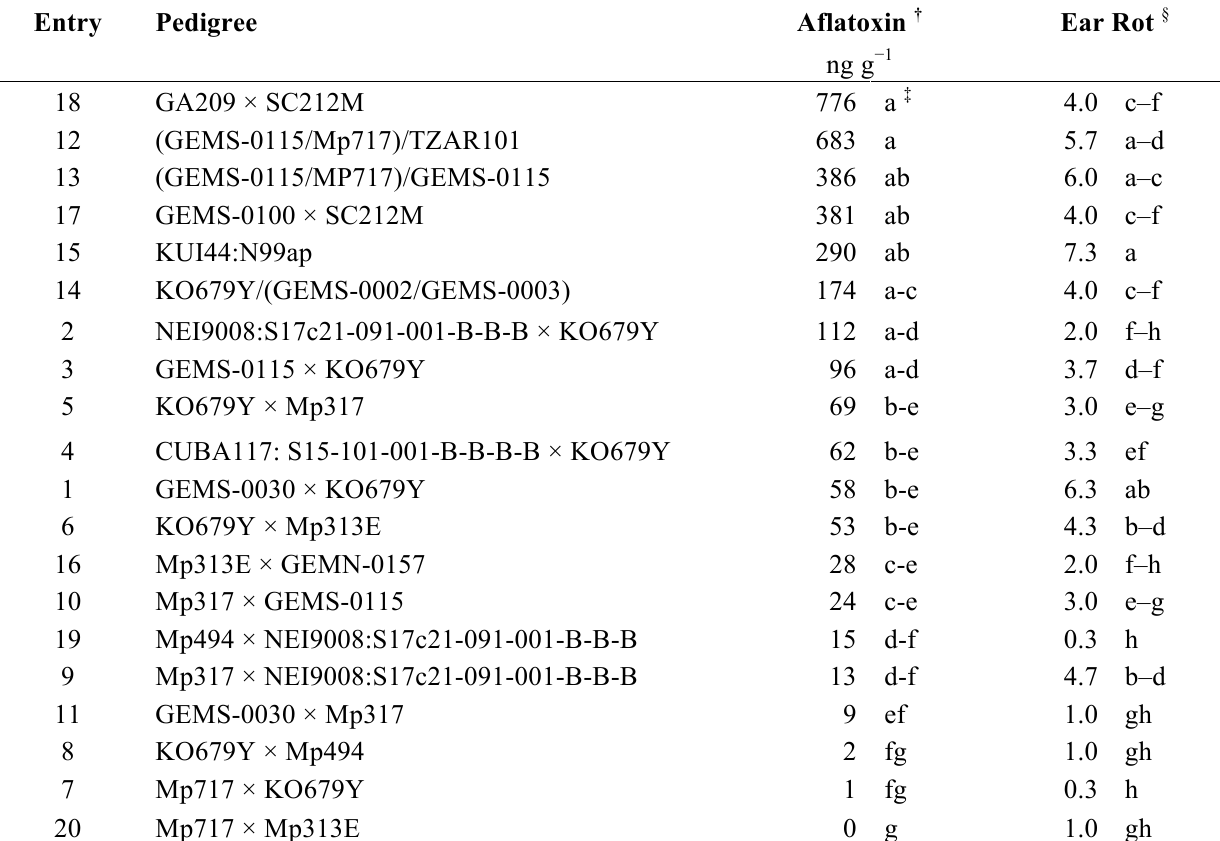
Table 5. Aflatoxin evaluation of corn hybrids and breeding crosses in 2011.